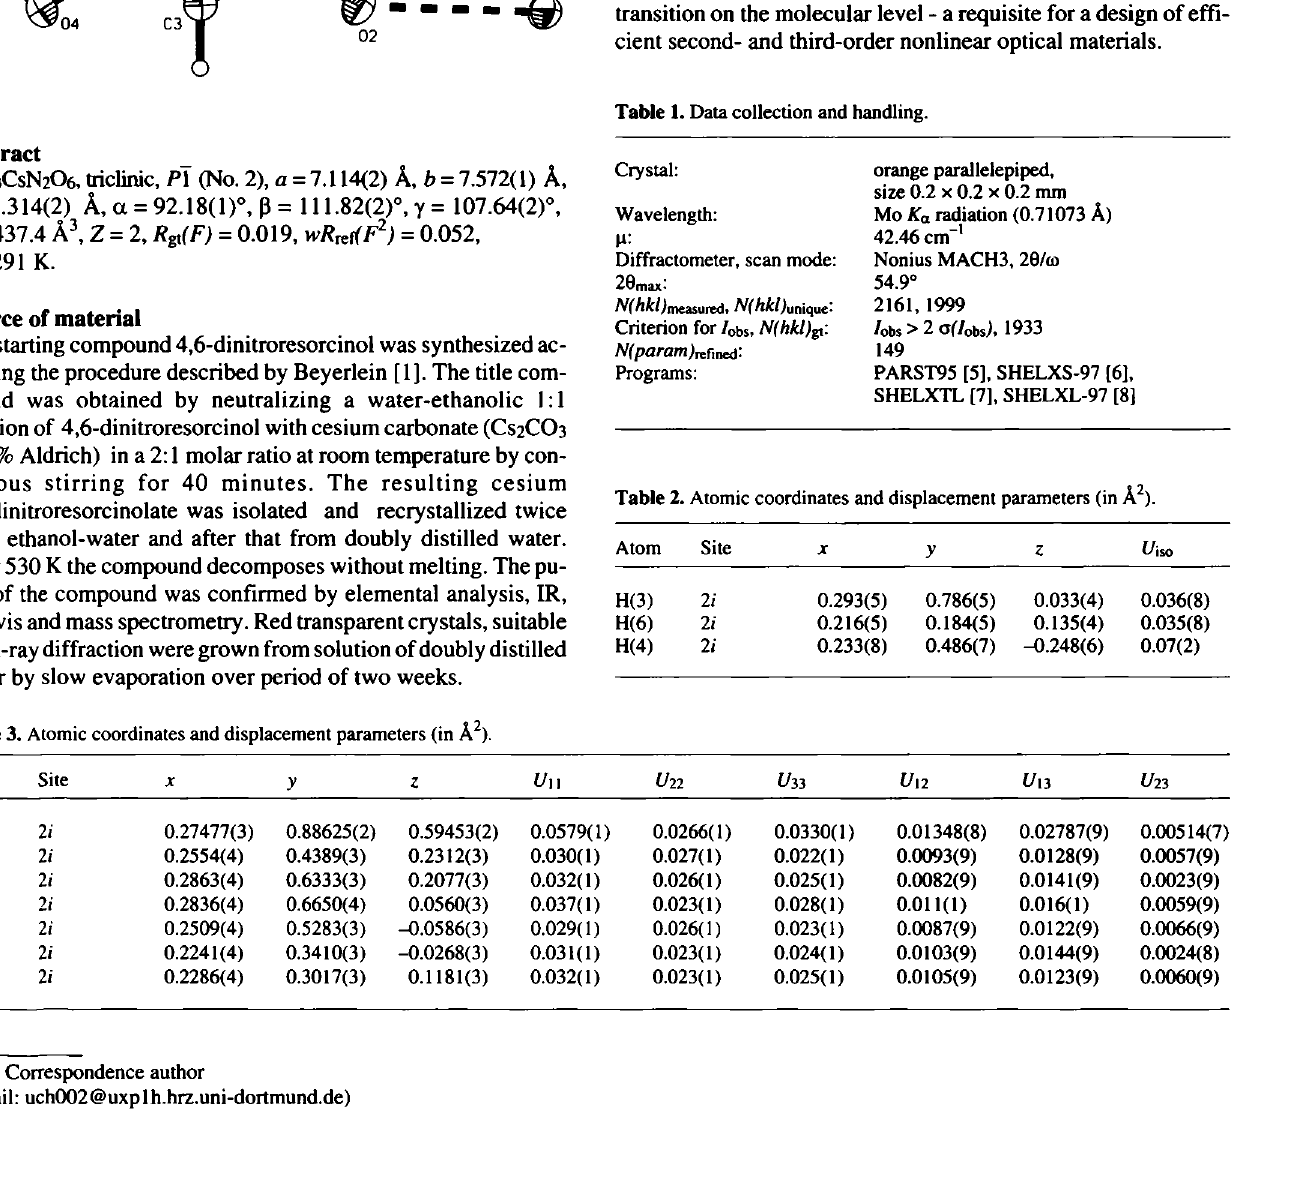
Table 1. Data collection and handling.